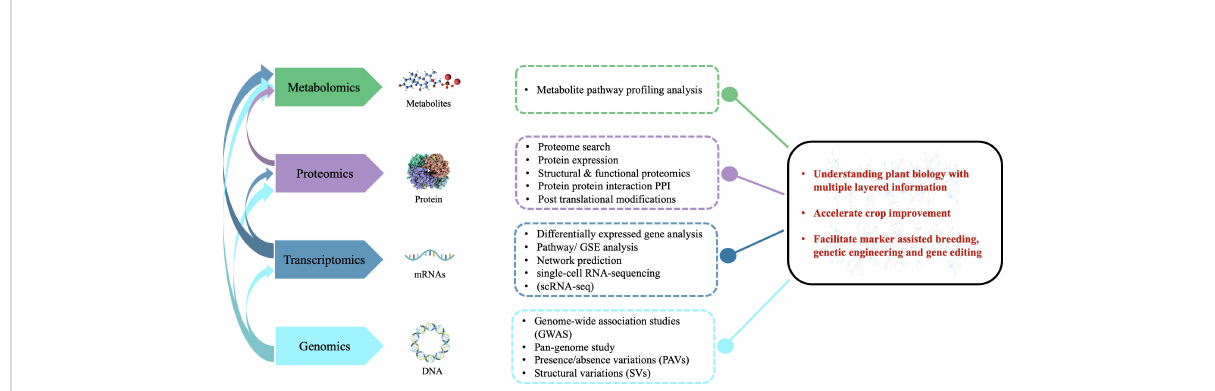
FIGURE 1 The prospects, limitations, and outlook for multi-omics based agricultural development in the future. Different multi-omics data layers, their interactions, the kinds of omics features found in each layer, and the methods used to evaluate omics data in various